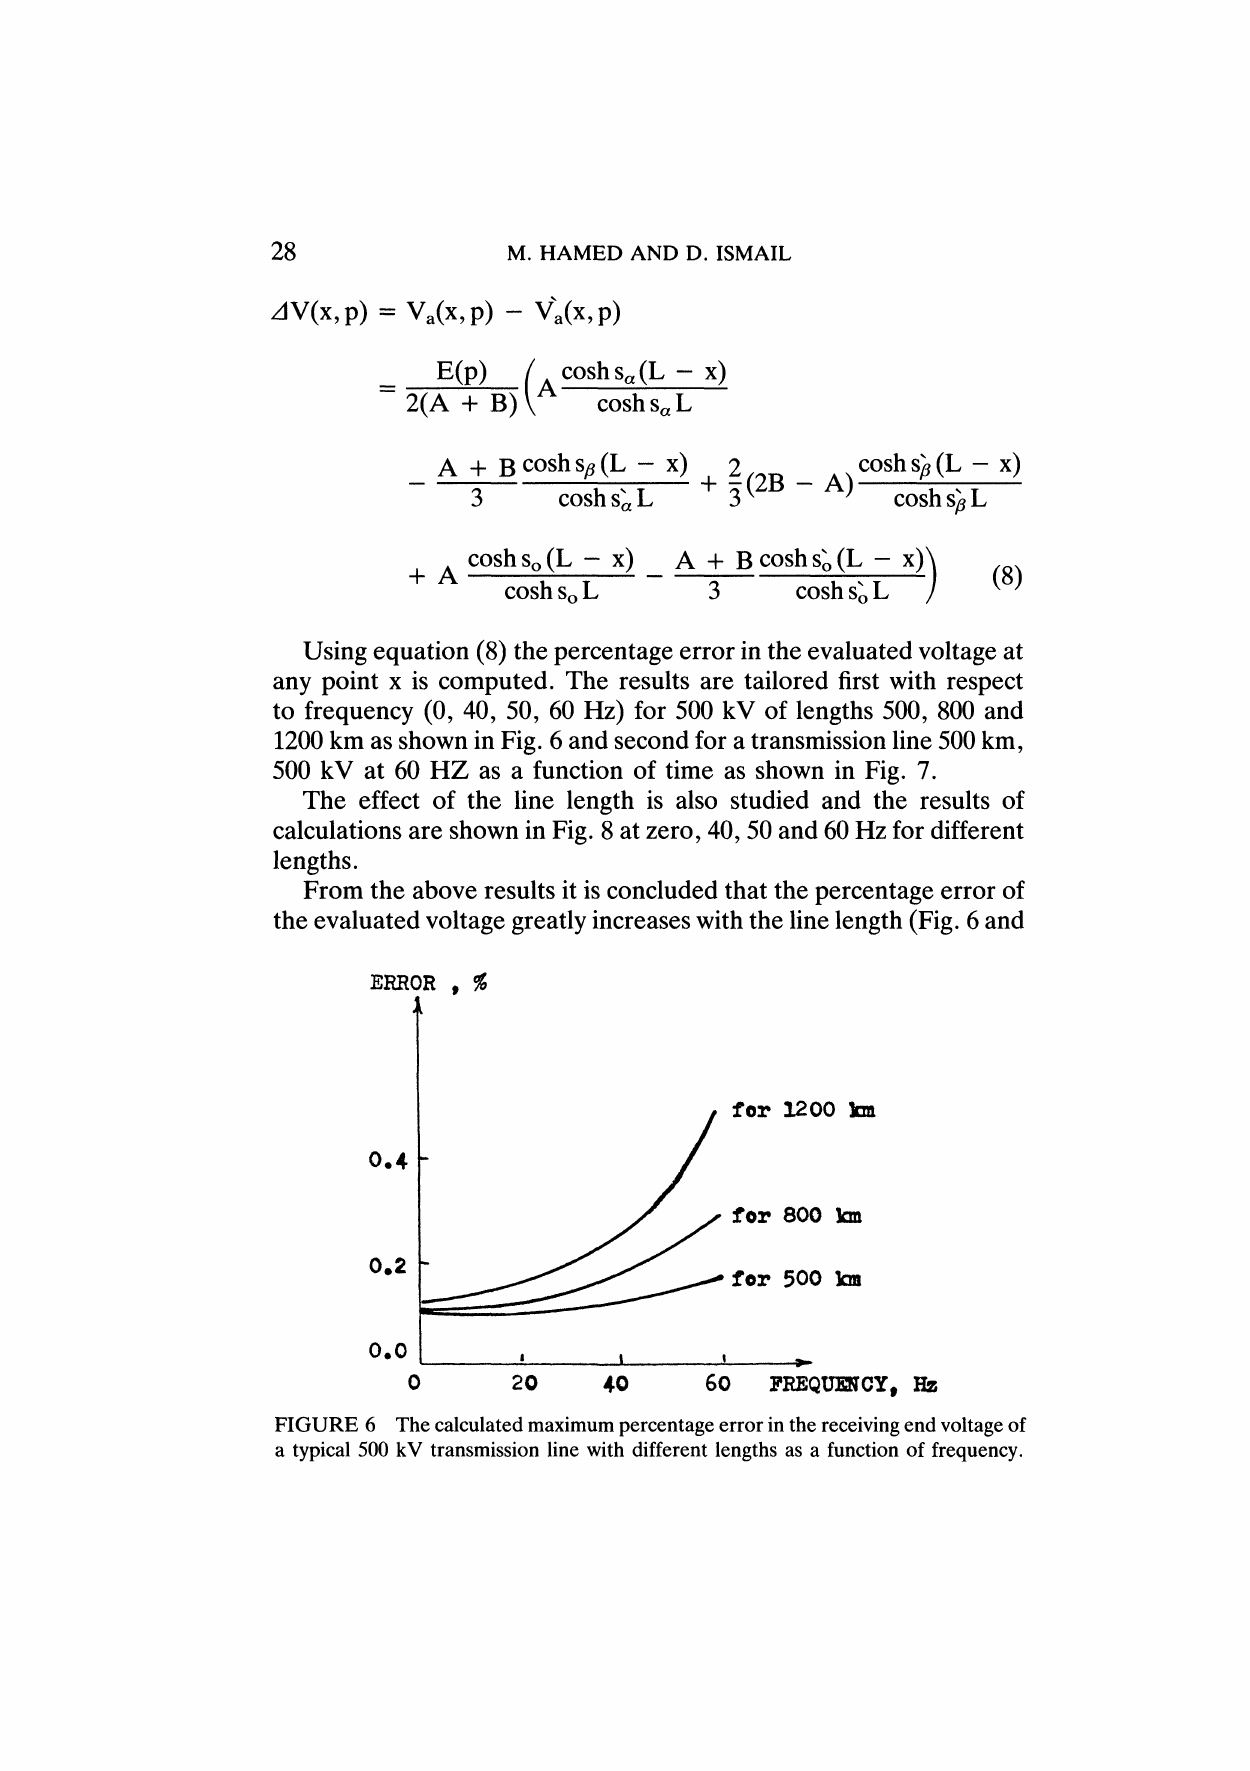
FIGURE 6 The calculated maximum percentage error in the receiving end voltage of a typical 500 kV transmission line with different lengths as a function of